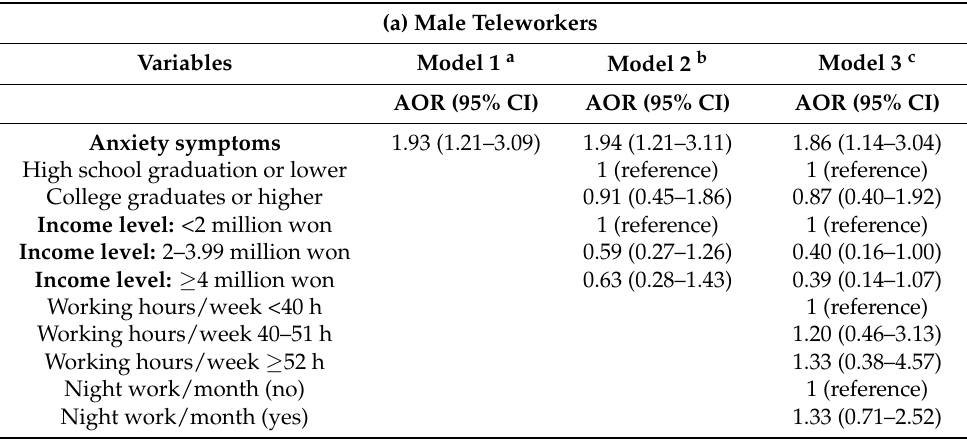
Table 3. Multivariate logistic regression for anxiety